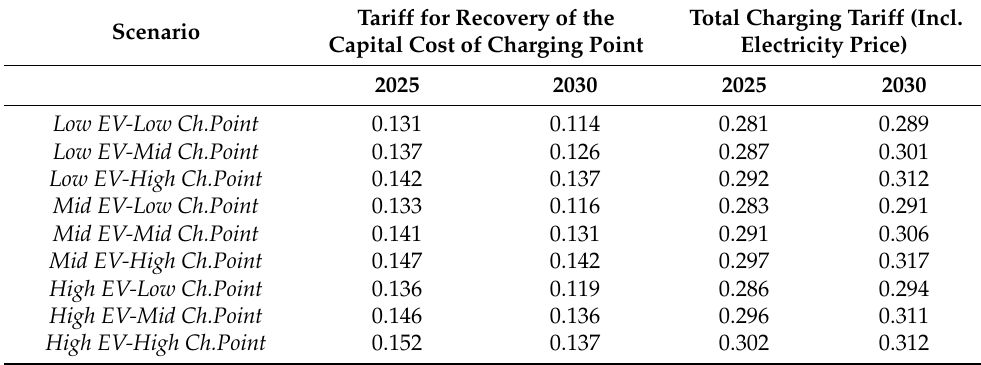
Total Charging Tariff (Incl. Electricity Price)